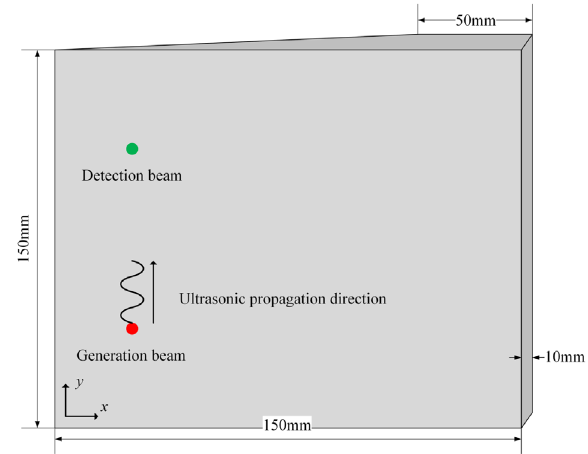
Figure 4. Schematic diagram of the wedge aluminum